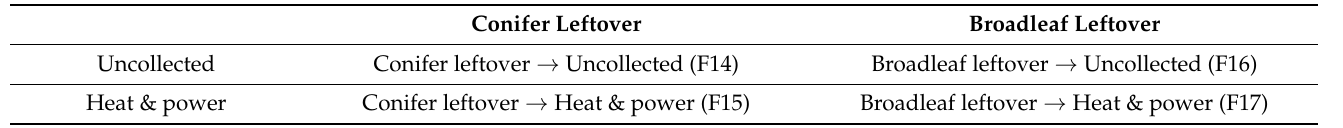
Table 2. LCW&R streams for primary forest residues.